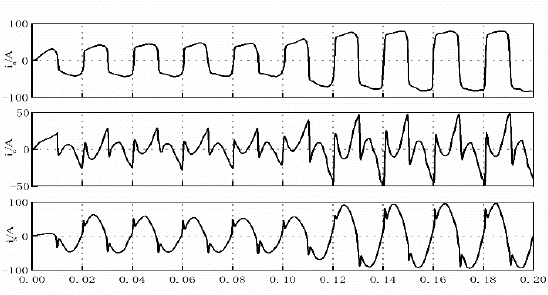
Figure 10. PI control load current, compensation current, and grid current waveforms.